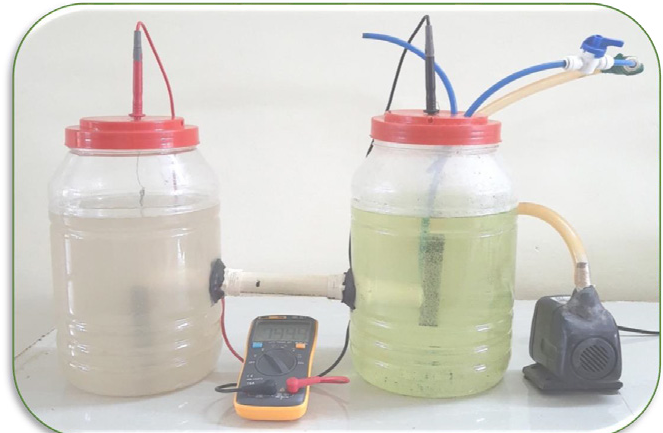
Fig. 1b: Photographic view of double chambered salt bridge microbial fuel cell